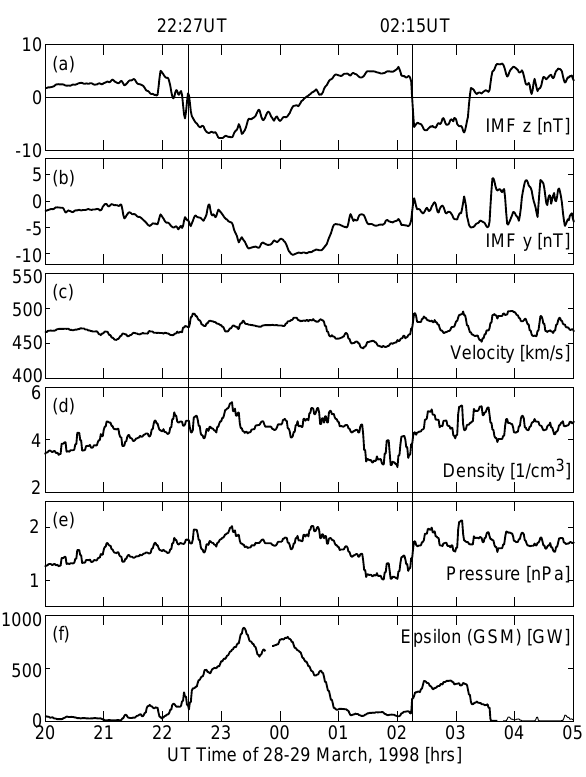
Fig. 1. (a) IMF B z component as recorded by the Wind spacecraft (in GSE coordinate system), (b) IMF B y , (c) solar wind velocity, (d) solar wind density, (e) solar wind dynamic pressure, (f) Aka- sofu’s epsilon parameter characterizing the input of energy to the magnetosphere (in GSM coordinate